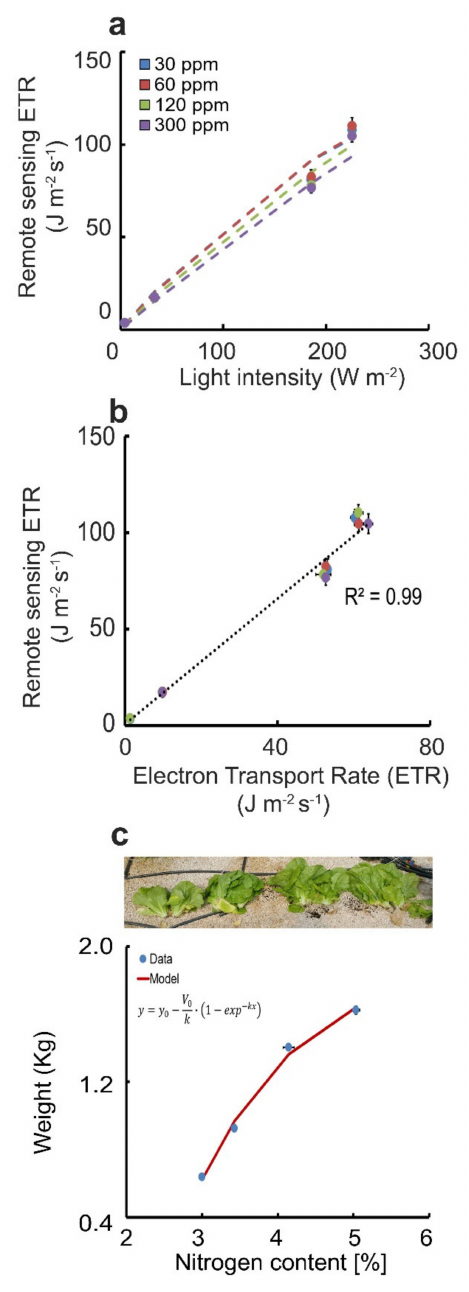
Figure 5. Linear correlation of ETR with the PAM measurements and predictions of plant health and photosynthesis performance. ( a ) Fertilizer treatments: 30, 60, 120, 300 ppm—color-coded as blue, red, green and purple, respectively (dots seen on the graph, n = 30). The dashed colored lines represent an average of the fit calculated points from Equation (3). ( b ) Remotely sensed ETR calculation correlated with the ground truth PAM calculation. Error bars represent standard errors of the mean. ( c ) Final weight of L. sativa measured two weeks after the measurement, at the end of the cultivation period. Error bars represent standard error of the mean, n =